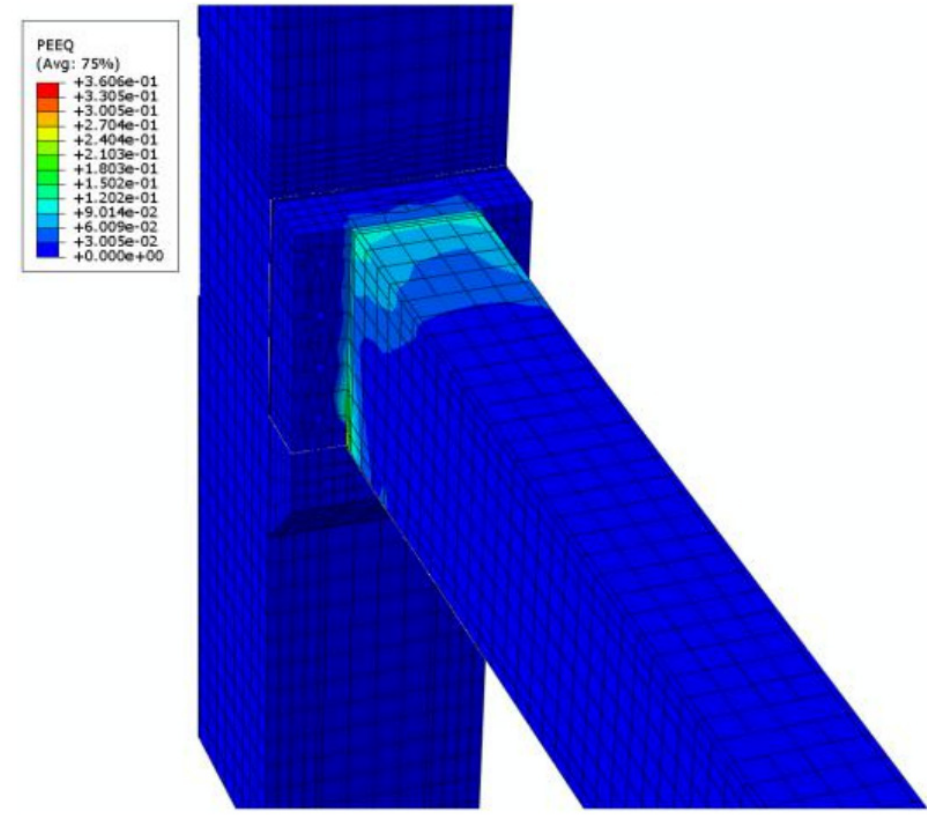
Figure 33. Equivalent plastic strain for FEM J3.